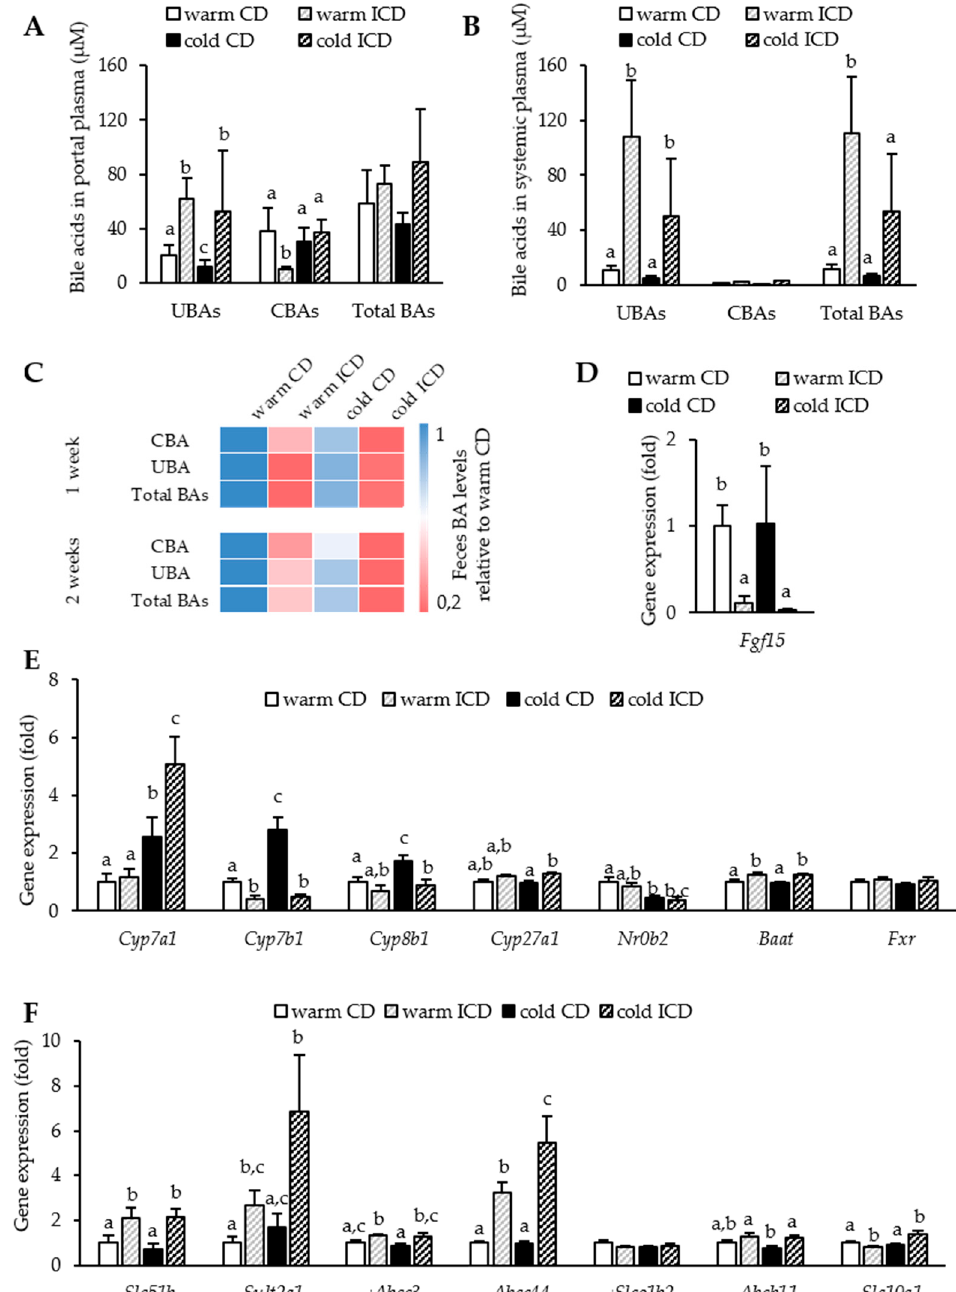
Figure 4. Inulin alters the bile acid metabolism. ( A ) UBA, CBA, and total bile acid levels in portal plasma and ( B) systemic plasma, and in feces ( C ). Relative expression of ( D ) Fgf15 in ilea; ( E ) genes involved in the synthesis of bile acids and its regulation in the liver. ( F ) Genes involved in the hepatic transport of bile acids. Levels are normalized to Tbp as the housekeeper. Data are shown as mean values ± SEM, and different letters indicate significant differences between groups ( p < 0.05) determined by two-way ANOVA. CD warm: n = 6; ICD warm: n = 6 (ICD warm BA portal plasma n = 5); CD cold: n = 6 (CD cold BA systemic plasma n = 4); ICD cold: n = 5. VBA: urine bile acids, CBA: conjugated bile acids.